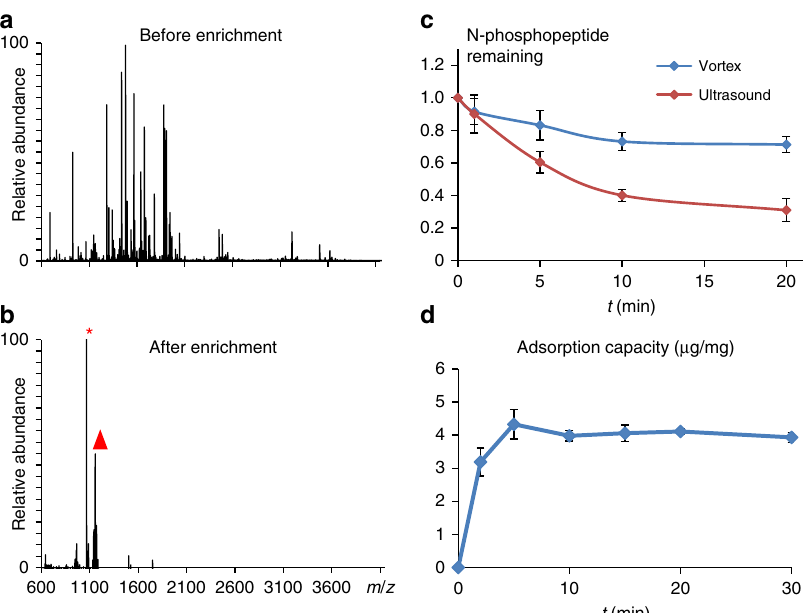
Fig. 3 Enrichment performance of SiO 2 @DpaZn. a MALDI-TOF/TOF spectra of TS p HYSIMAR spiked in BSA digests at 1:100 (m/m) before and b after enrichment by SiO 2 @DpaZn. Triangle indicates the N-phosphopeptide, and asterisk indicates the dephosphorylated counterpart TSHYSIMAR. c Degradation curve of N-phosphopeptide in vortex and ultrasound treatment under neutral condition. Each represents the mean from n = 3 parallel experiments, and the mean represents recovery of phosphopeptide. The error bar is represented by SD. d Adsorption kinetics of SiO 2 @DpaZn. Each value represents the mean from n = 3 parallel experiments, and mean represents adsorption capacity of SiO 2 @DpaZn. The error bar is represented by